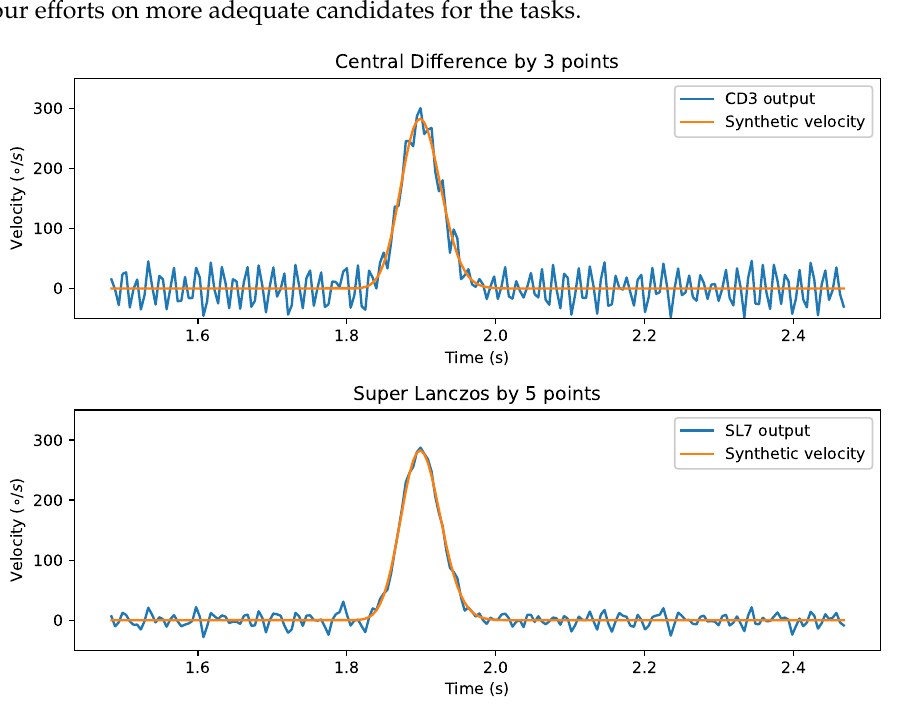
Figure 3. Comparison between the best central difference method and the worst of the rest of the families. The signal is from a healthy synthetic signal with saccades of 20 ◦